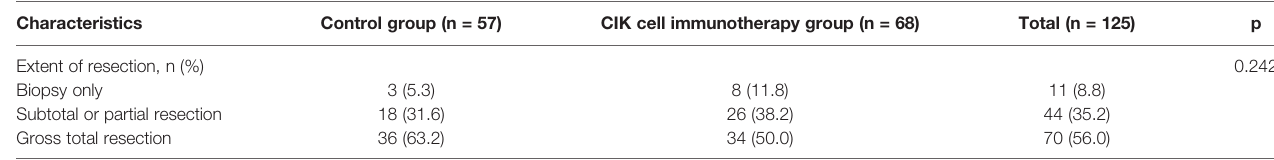
TABLE 3 | Comparison of extent of resection between the CIK cell immunotherapy group and control group in patients with pure GBM in the mITT population.